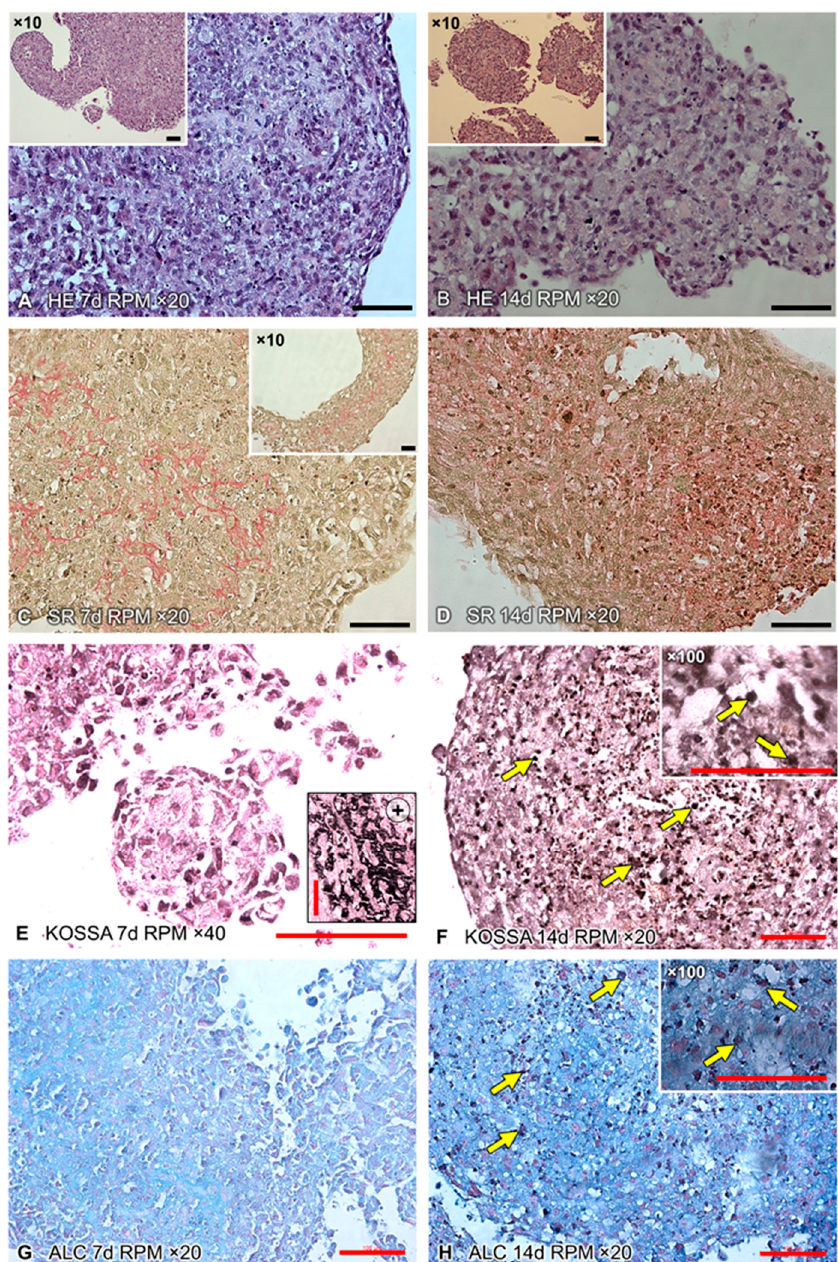
Figure 2. Histological assessment of paraffin-embedded cross-sections. The hFOB 1.19 cells were cultured for 7 days and 14 days on the RPM. 3D constructs were collected and, subsequently, paraffin-embedded. ( A , B ) HE staining shows the substantial aggregation of cells after 7 days and 14 days. ( C , D ) Sirius red-stained samples reveal a substantial collagen deposition. A clear increase is visible after 14 days, compared to 7 days. The black arrows indicate collagen deposition (red). Two stains were used to analyse biological mineralization within the MCS. ( E , F ) The von Kossa stain (KOSSA) is widely used for the detection of calcinosis in tissues. The small picture in ( E ) shows a positive control. ( G , H ) The Alcian blue (ALC) dye labels anionic tissue components, such as hyaluronate or chondroitin sulphate. The yellow arrows in ( F ) and ( H ) indicate regions of early calcification after 14 days. Scale bars: 100 µ m, d, days.